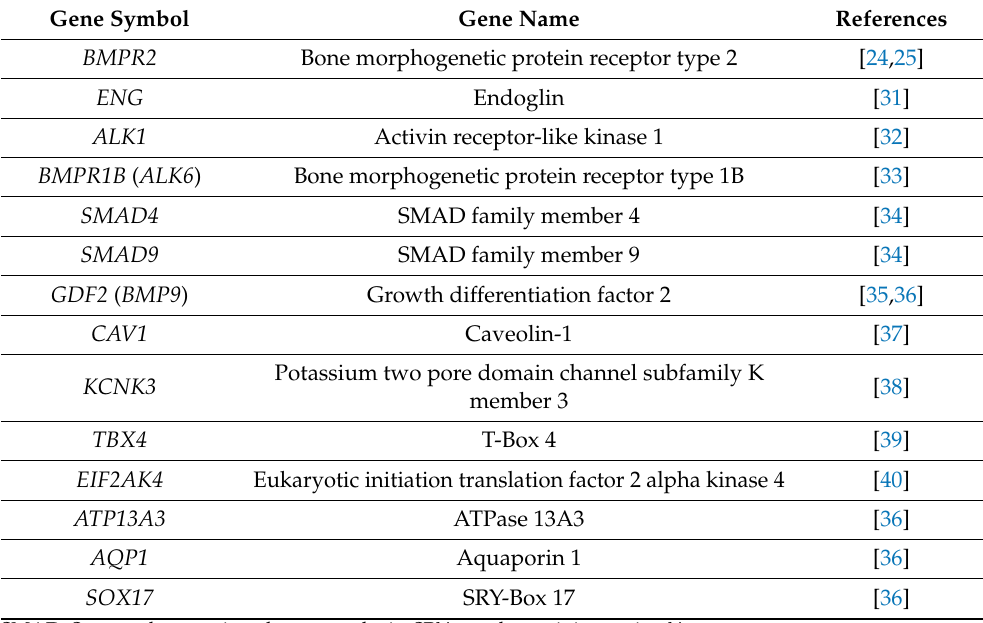
Table 1. Details of the gene mutations reported to be associated with pulmonary arterial